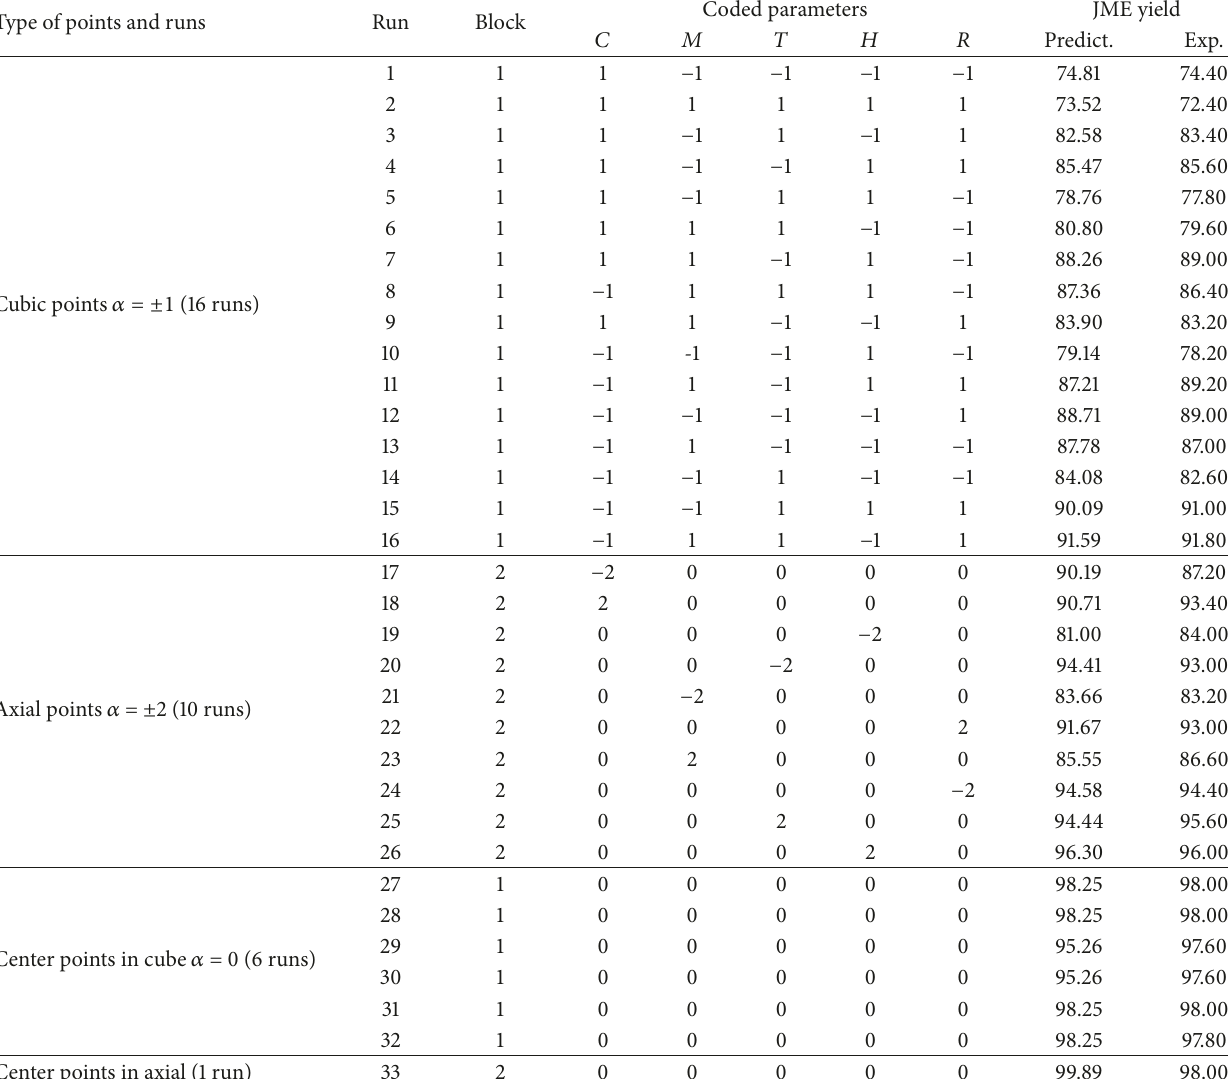
Table 2: The CCD design matrix for JME yield prediction